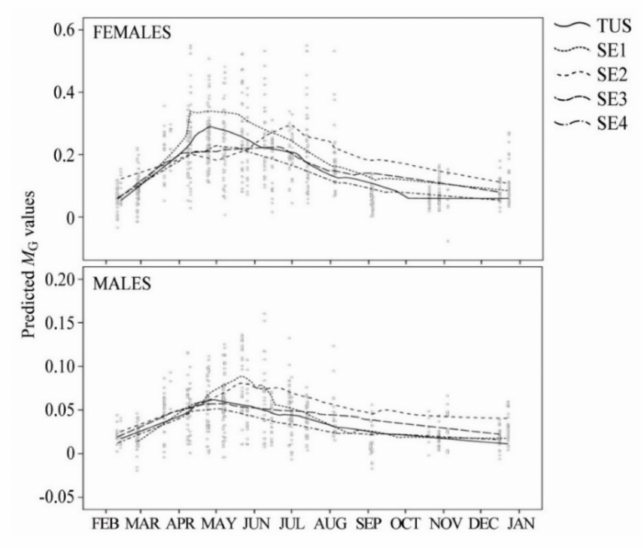
Figure 2. Temporal variation in gonad activity (predicted M G values, M G is gonad mass) along the study period for the five studied populations (TUS, SE1, SE2, SE3 and SE4) for both sexes of Gobio lozanoi . The lines represent the adjusted model Loess for each